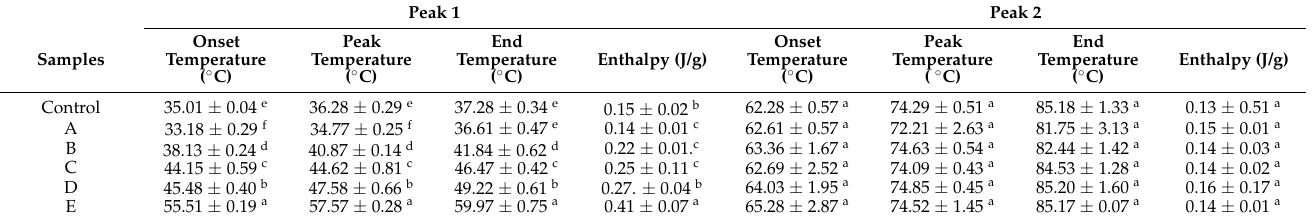
Table 5. The thermal denaturation temperatures and enthalpies of the fat-replaced samples with palm shortenings (PS) of various melting ranges (MR) as compared to the control sample with chicken skin. Peak 1 Peak